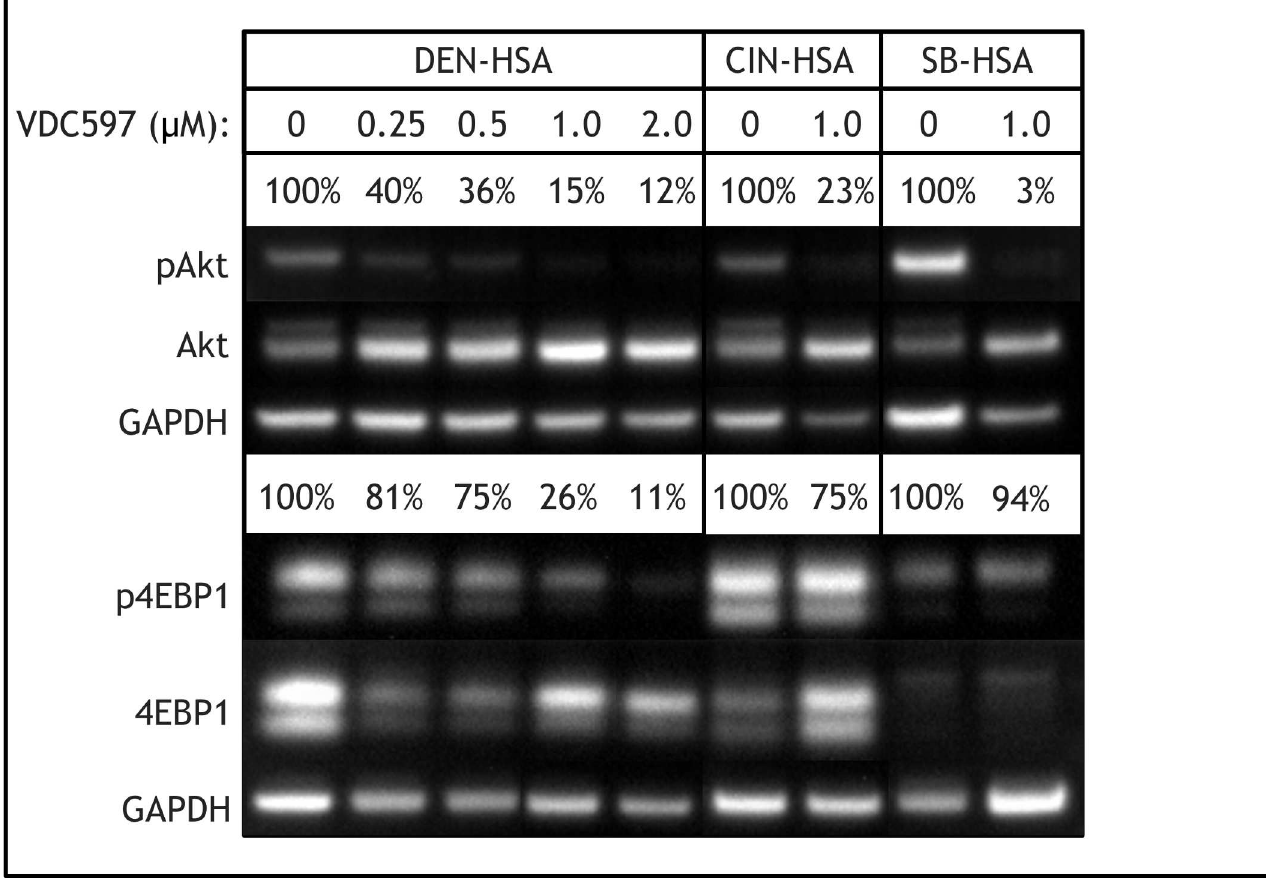
PLOS ONE | https://doi.org/10.1371/journal.pone.0200634 July 16,